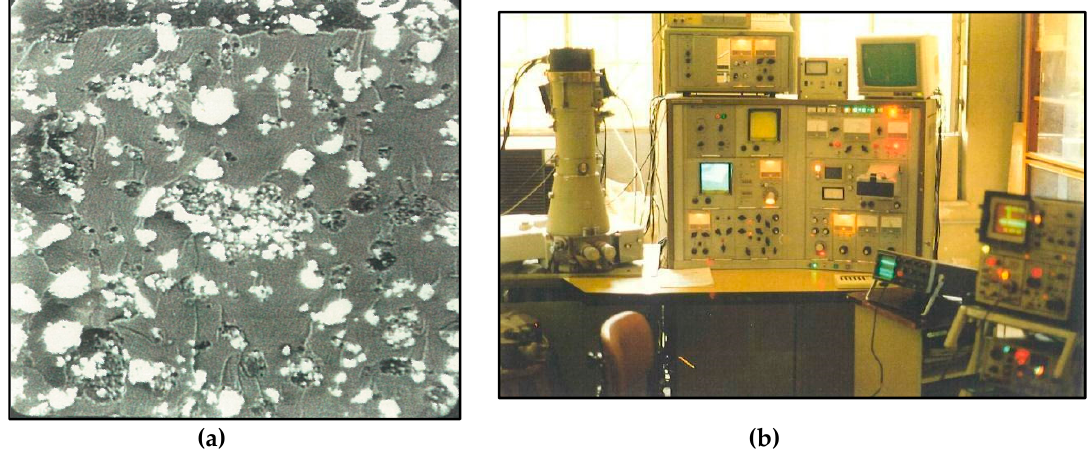
Figure 6 Differential thermal analyzer ( a ) and differential scanning calorimetry (DSC) analyzer ( b ) for the measurement of interphase thickness.